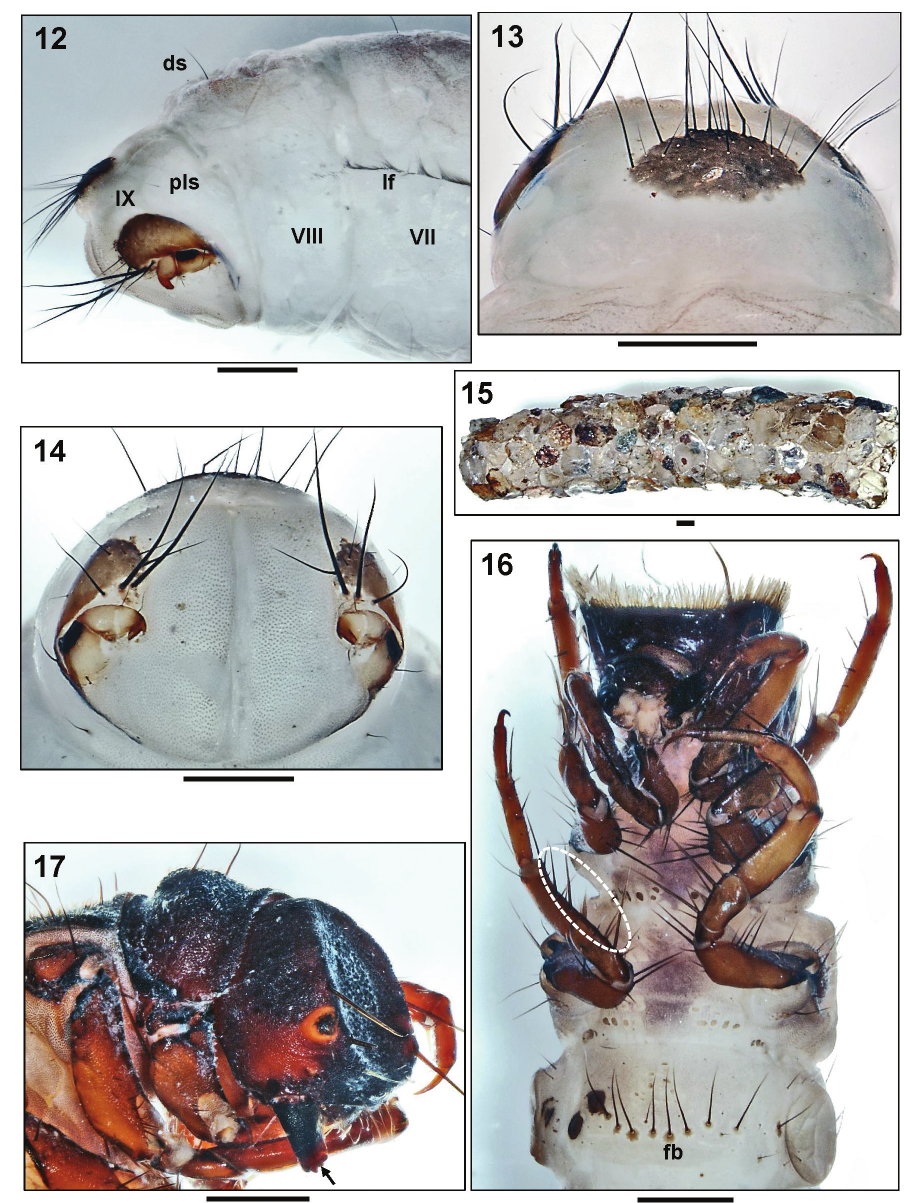
right lateral view (lf: lateral fringe; pls: posterolateral seta; ds: dorsal seta) 13 Abdominal segment IX, dorsal view 14 Tip of abdomen, posterior view 15 Larval case, right lateral view 16 Drusus macedonicus Schmid, 1956, 5 th instar larva, head, thorax and abdominal segment I, ventral view (fb: filtering bristles, dotted oval: filtering bristles on hind femur) 17 Drusus muelleri McLachlan, 1868, 5 th instar larva, head, pro- and mesothorax, right lateral view (arrow: mandibles with terminal teeth). Scale bars: 0.5